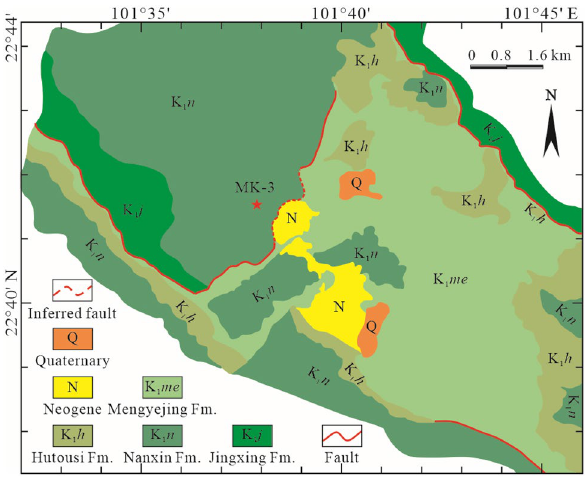
Figure 1. Geological map of the Mengyejing potash mining area and the location of well MK-3. In the map, the locations of the potash deposit, the MK-3 well and the distributions of faults and strata are